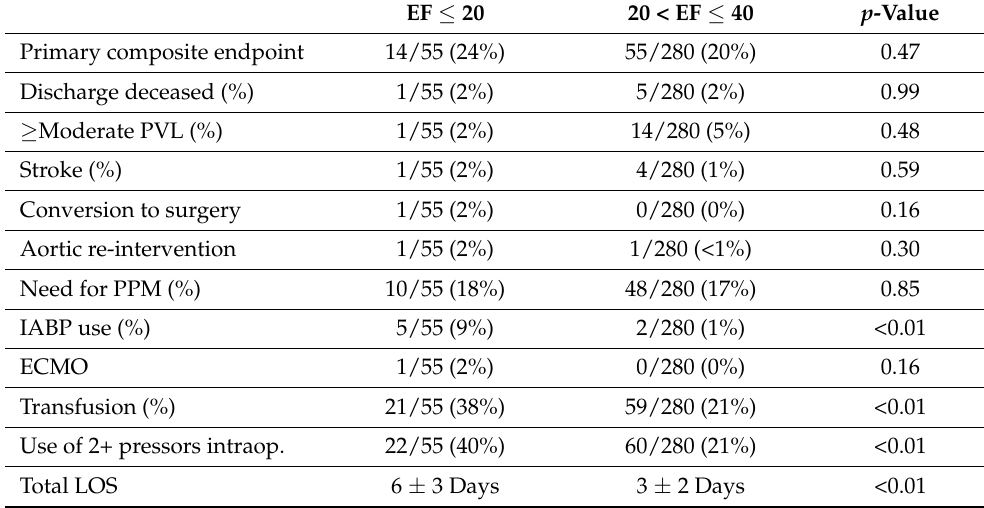
Table 2. Periprocedural outcomes.